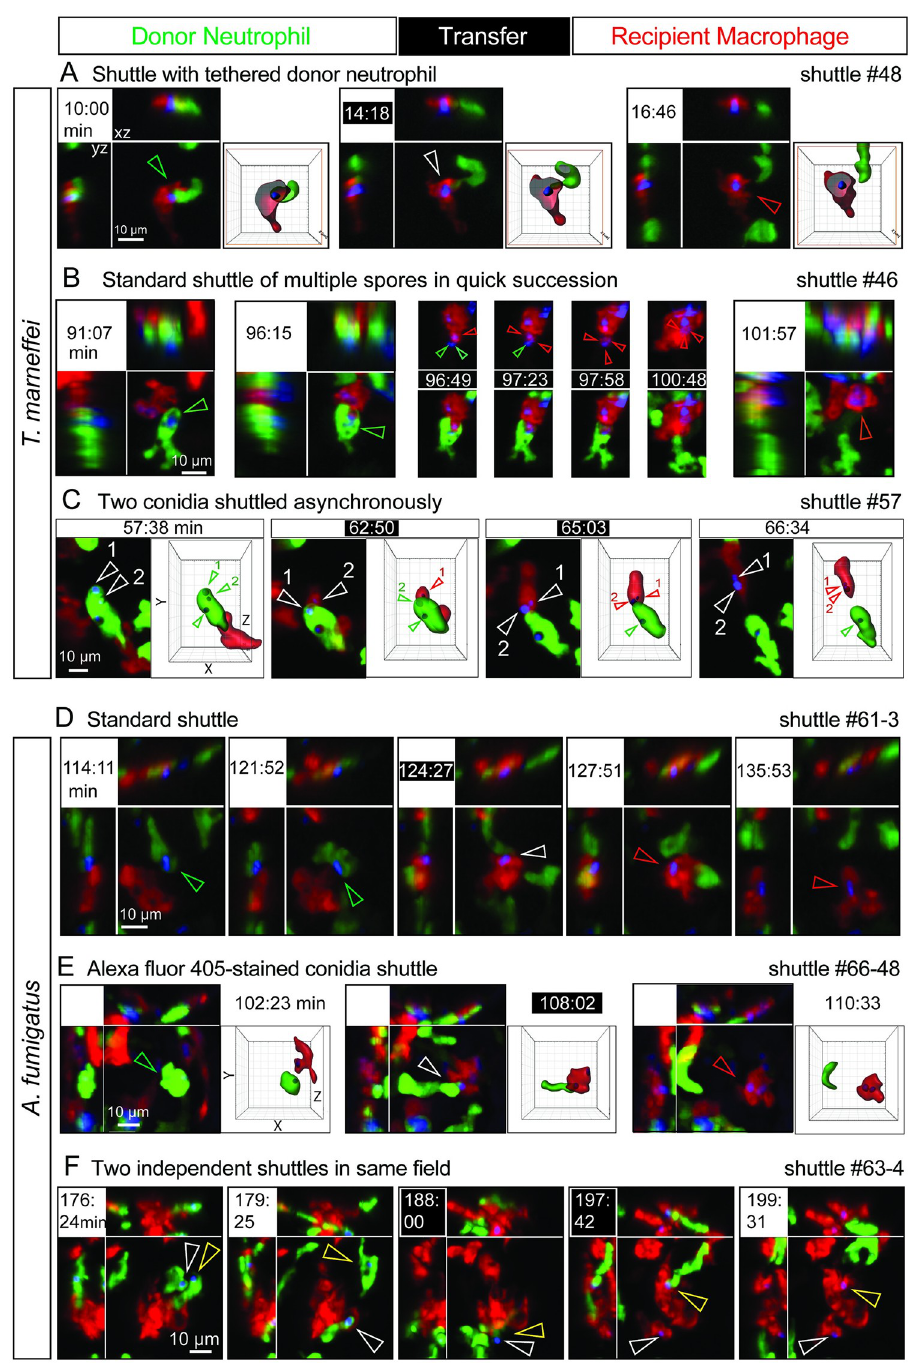
Fig 2. Variant shuttles of fungal conidia from neutrophil to macrophage. A variety of shuttles of conidia (blue) from Tg(mpx : EGFP) neutrophils (green) to Tg(mpeg1 : Gal4FF)×(UAS-E1b : Eco . NfsB-mCherry) macrophages (red). In each example, panels include isometric orthogonal yz and xz views corresponding to the xy maximal intensity projection and indicate the time in min from start of movie. Time points colored white-on-black are the moments of transfer. (A,C,E) include volume-rendered views corresponding to the maximal intensity projection; where this volume is sectioned (as in panel A), the framing box is shown in red. Colored arrowheads indicate the conidium within donor neutrophil (green), at the point of intercellular transfer (white), and in the recipient macrophage (red). (A–C) Shuttles of T . marneffei conidia. (A) Shuttle demonstrating tethering of the donor neutrophil at the moment of transfer. (B) Shuttle of multiple conidia from one donor neutrophil in quick succession. First two frames show